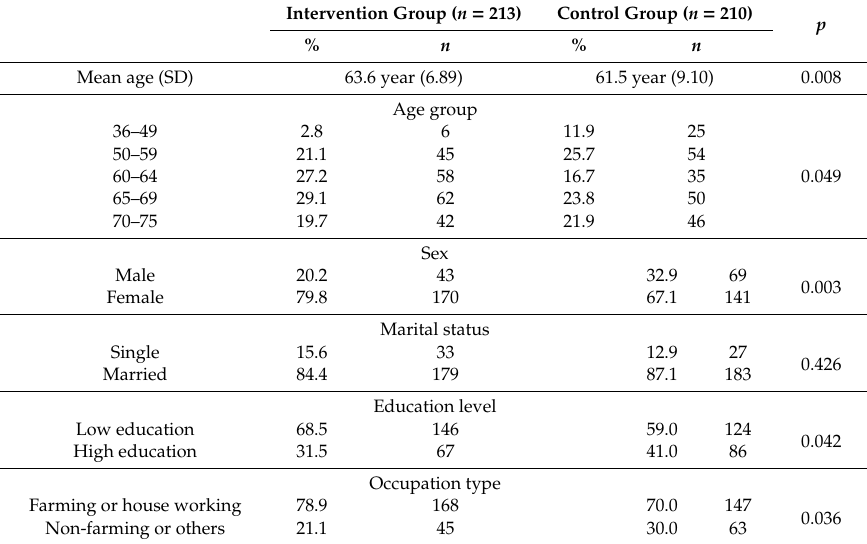
Table 1. Sociodemographic characteristics of participants at baseline data